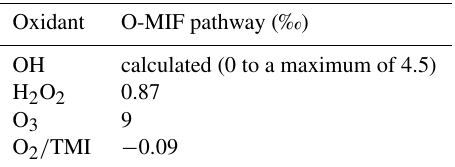
Table 4. O-MIF signatures of S(IV) oxidation pathways in the